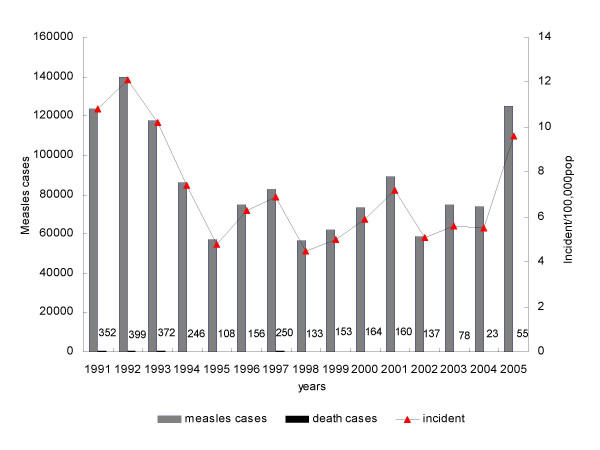
Average number of measles cases, reported death and average measles incidence in 2005, China. Number of reported deaths for each year is indicated above.